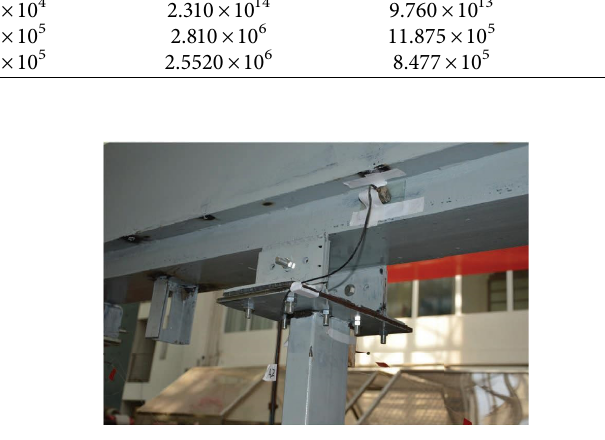
Figure 2: Connection of fxed bearing pier.